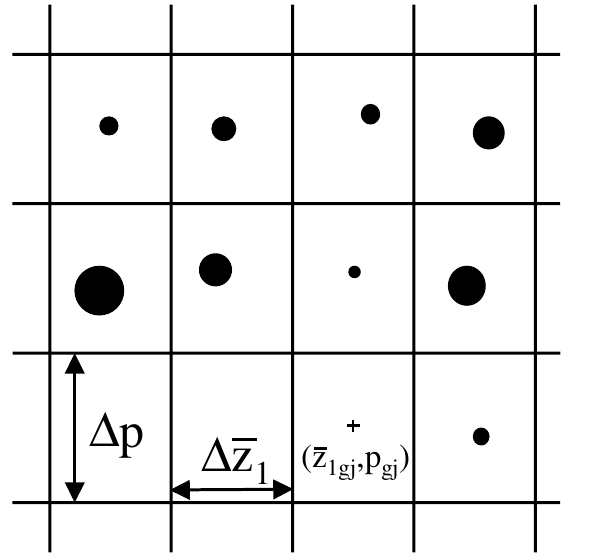
FIG. 3. Schematic of macroparticle loading algorithm. The bottom left three grid boxes show the notation used for the grid dimensions and center. The randomness in the macroparticle charge via the Poisson random variate N their different relative sizes. The noise due to the random positioning is demonstrated via the variation about the grid centers.